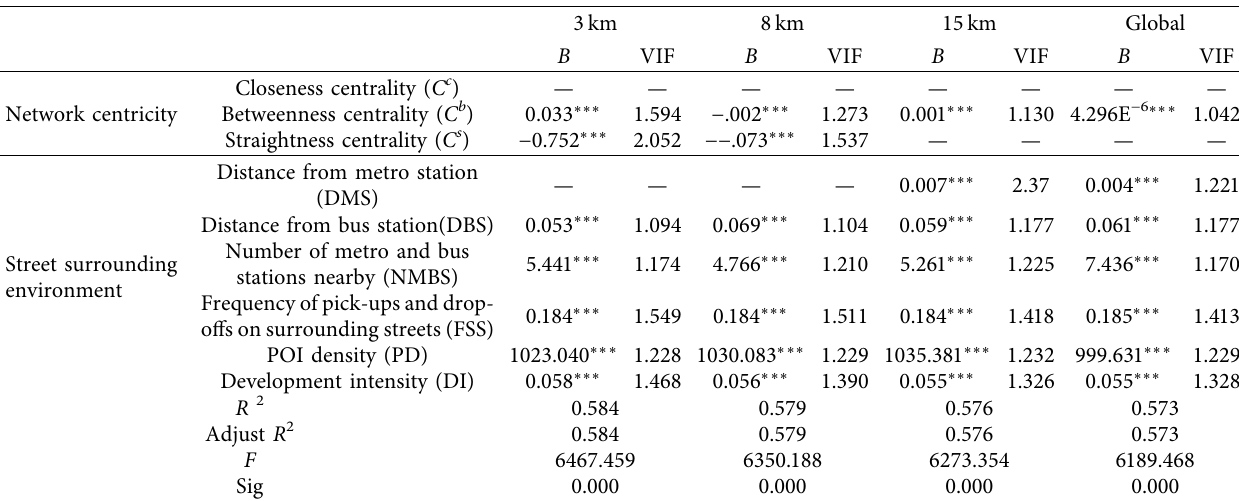
Table 4: Regression analysis